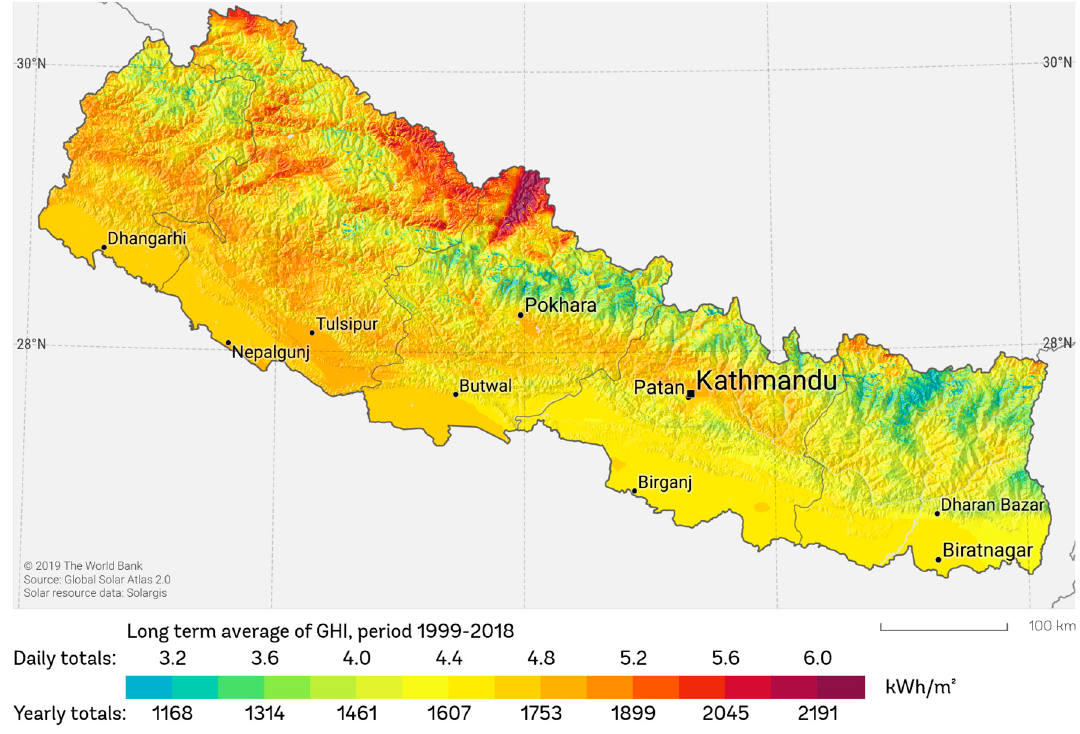
Figure 1. PV power potential in Nepal [11].